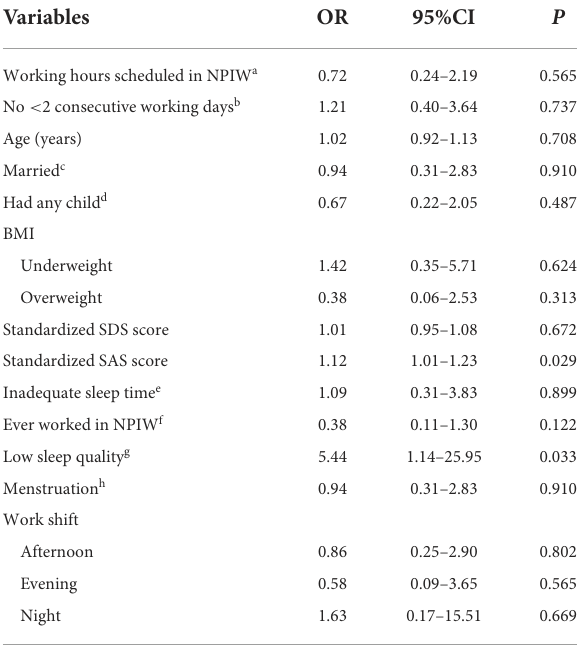
TABLE 2 Univariate analysis for the relationship between variables and 1 BP for nurses working in NPIW.